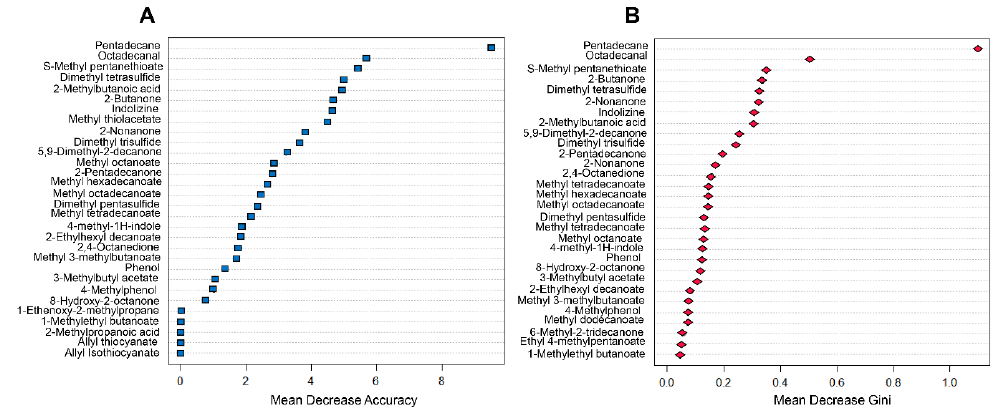
Figure 5. Assessment of variable importance, in terms of ( A ) mean decrease in accuracy and ( B ) mean decrease Gini or node impurity.